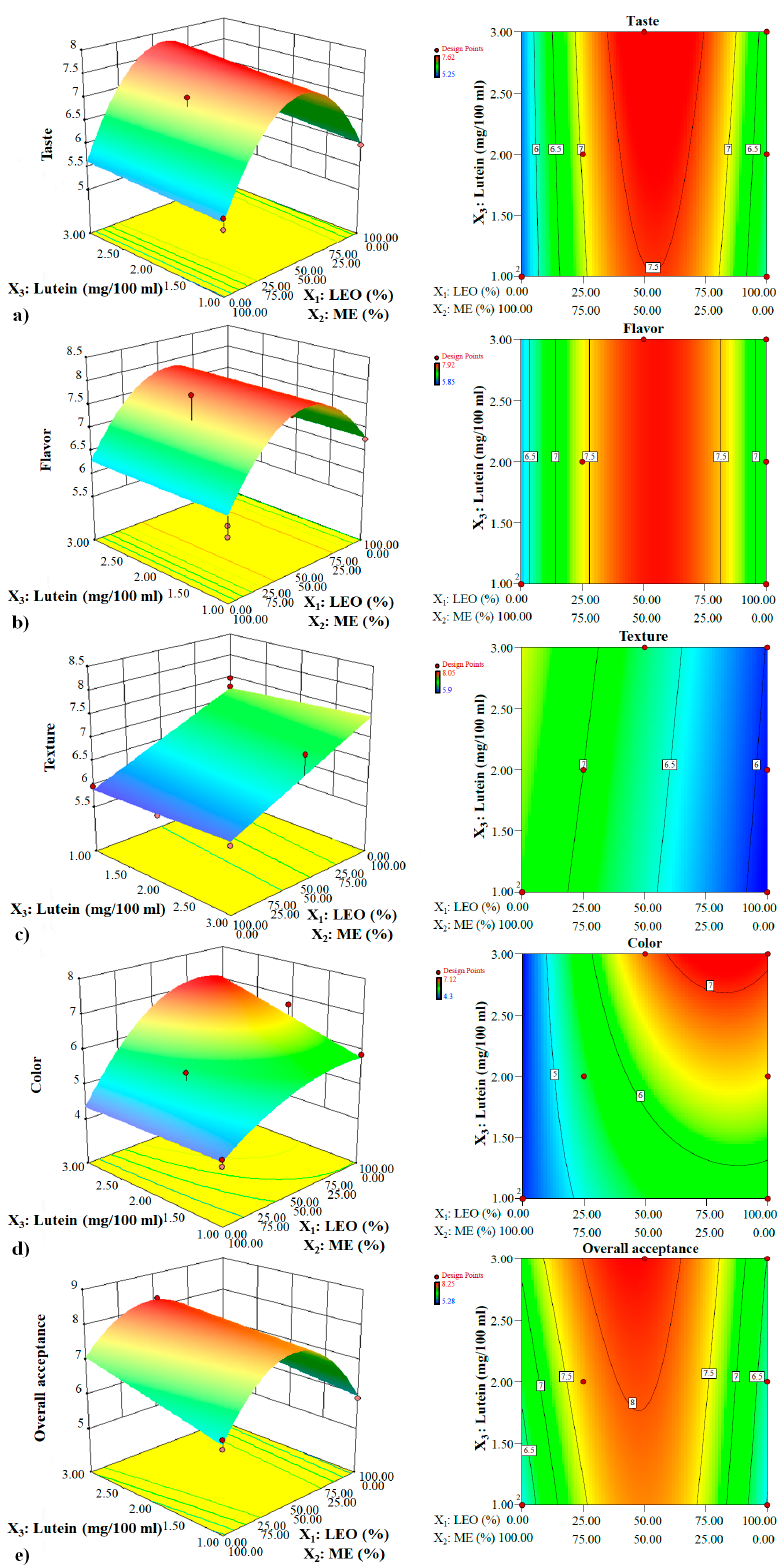
Figure 2. The change in ( a ) taste, ( b ) flavor, ( c ) texture, ( d ) color, and ( e ) overall acceptance based on different LEO and ME combinations under different lutein levels and in the presence of prebiotic fibers (in color) .